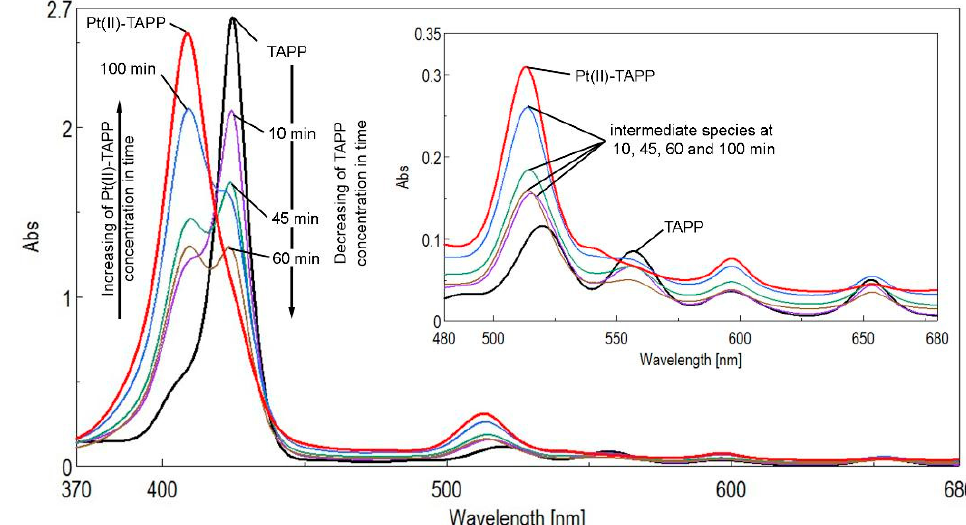
Figure 2. Monitoring the reaction progress of forming Pt(II)-TAPP by increasing the absorption intensity at 410 nm and decreasing the intensity of the TAPP absorption bands at 425 nm. In detail the differences between the Q bands of TAPP, Pt(II)-TAPP and intermediate species.